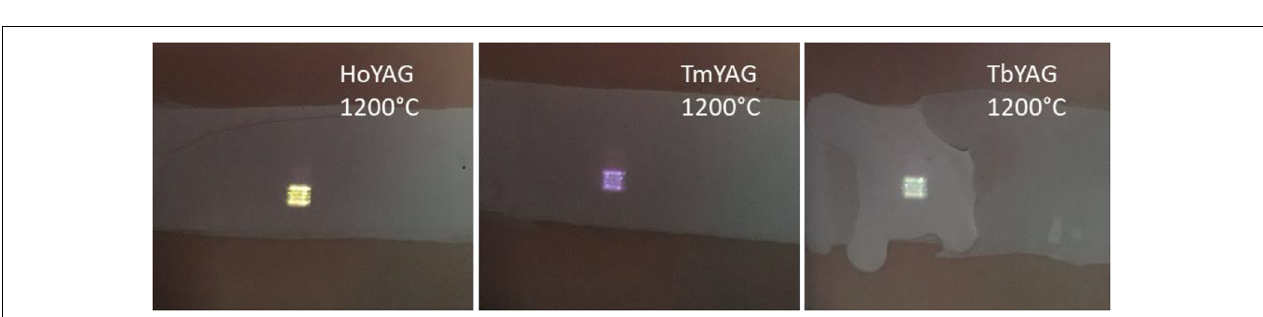
FIGURE 7 | Log–log plot of the UC signals as a function of laser excitation power in annealed nanogarnets, and table with the number of photons involved in the UCPL.